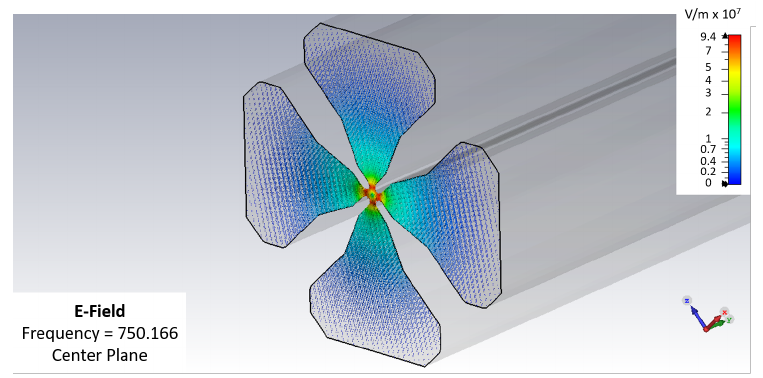
Figure 11. Quadrupolar electric fields in a transversal cut of the RFQ